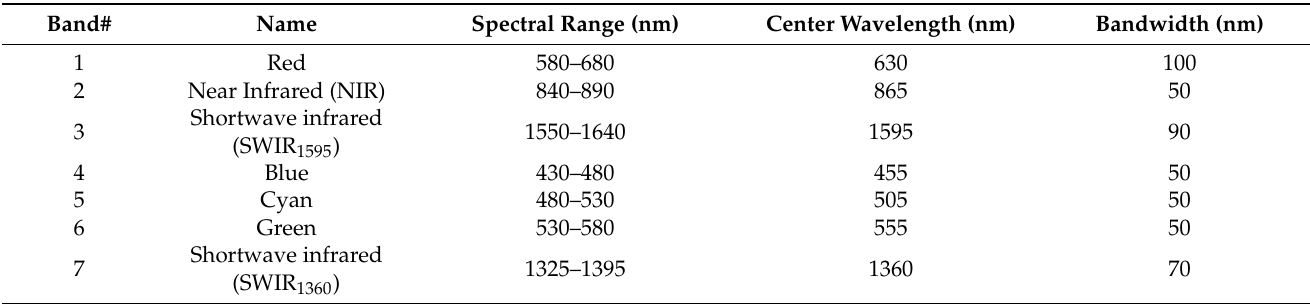
Table 3. The spectral characteristics of FY-3C VIRR bands used in this